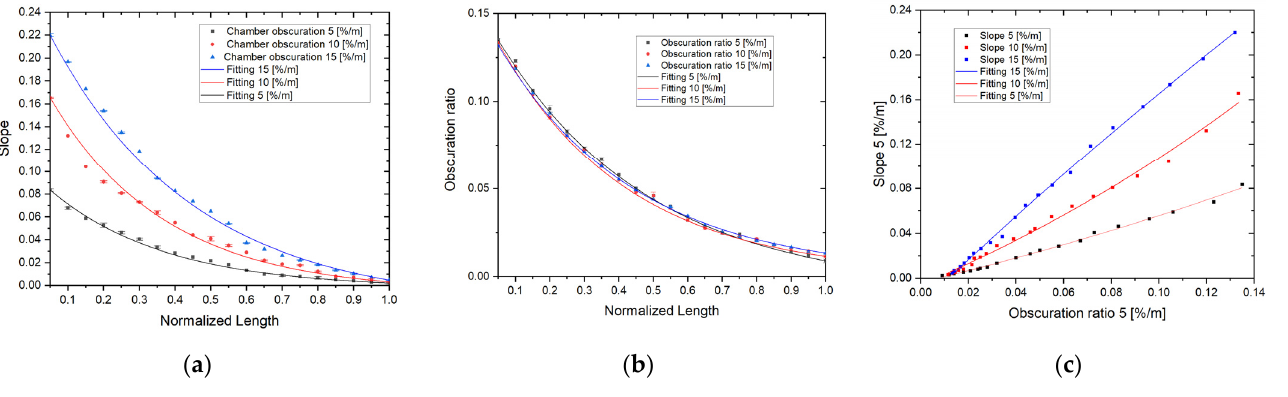
Figure 8. The obscuration at ASD ( a ) When chamber obscuration was 5%/m ( b ) When chamber obscuration was 10%/m ( c ) When chamber obscuration was 15%/m.